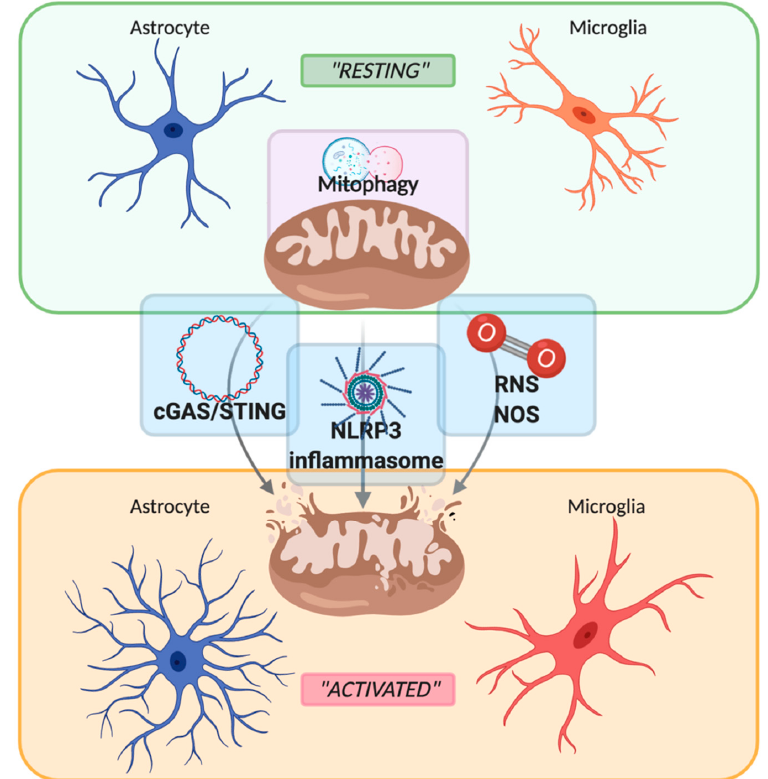
Figure 1. Schematic representation of the switch between “resting” and “activated” state of astrocyte and microglia mediated by mitochondria. Mitochondria maintain their healthy and physiological state by mitophagy. Upon stressful condition, such as inflammatory stimuli, mitochondria are disrupted with the consequent release of mtDNA, damage-associated molecular patterns (DAMPs), reactive oxygen/nitrogen species (ROS and RNS), leading to the activation of the sentinel of the central nervous system such as astrocytes and microglia. Created with BioRender.com.